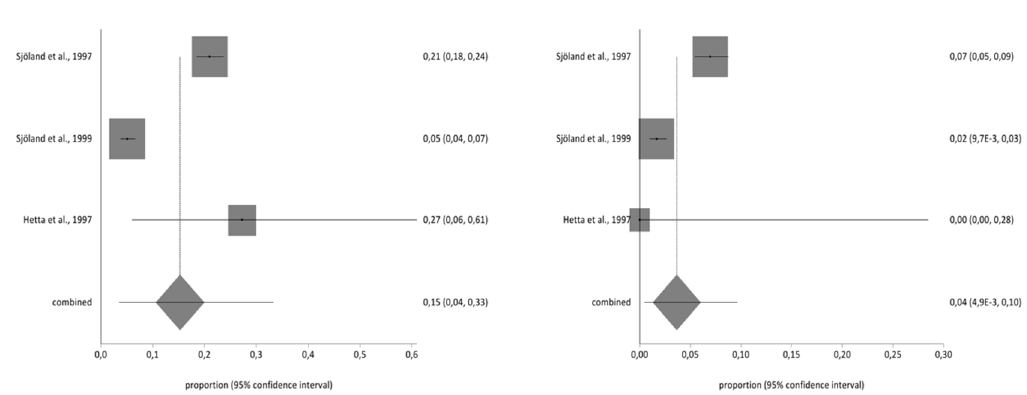
Figure 4. Pre- and post-impact on social life.